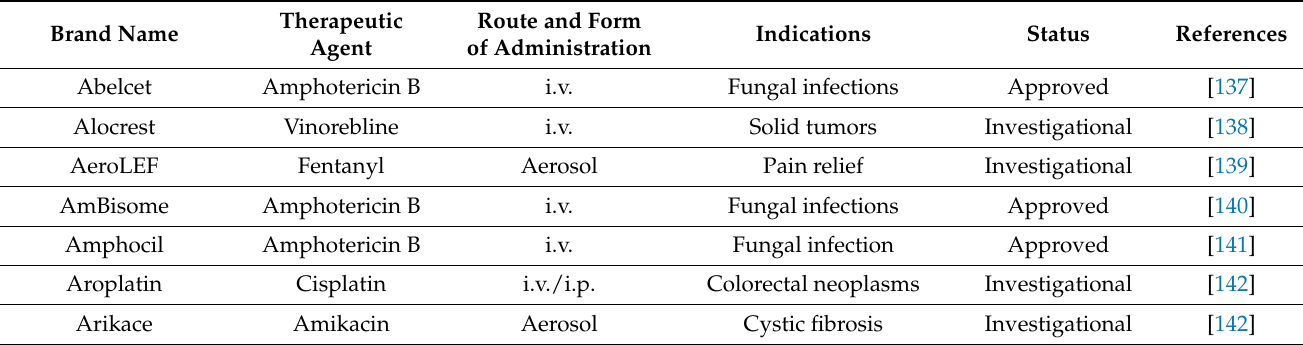
Table 3. Liposomal formulations used in